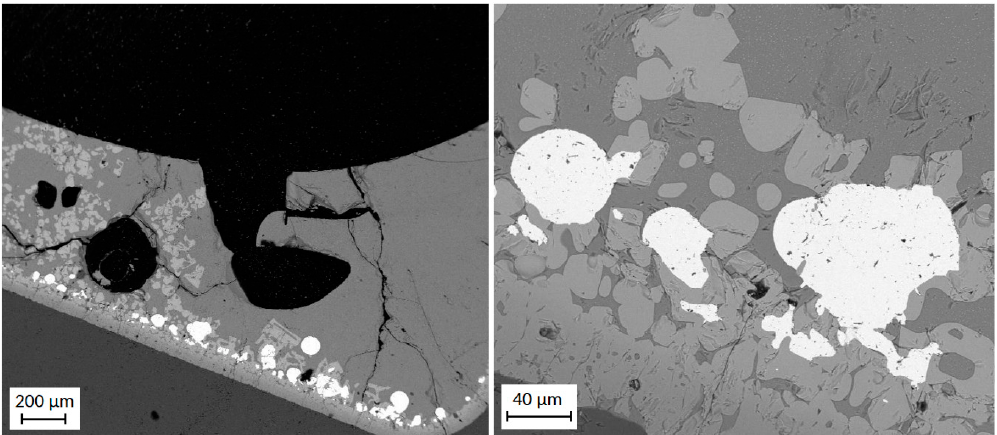
Figure 3 . Left side: SEM-BSE micrograph of sample V38 (pO 2 10 − 6 atm, 5 wt % K 2 O). Numerous loose spinel grains were observed floating in the liquid slag and the number of sticking copper alloy droplets was much higher compared to Figure 2. Right side: a close-up of the entrained copper droplets in the same sample; the shape of the liquid droplets has adapted to the surrounding solid spinel structure.